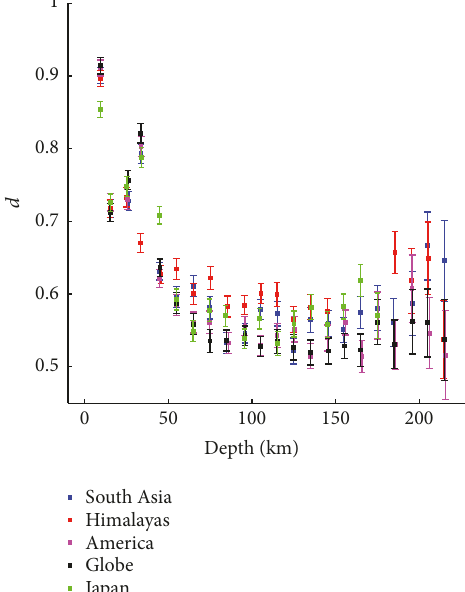
Figure 4: Variation with the depth of 𝑑 , calculated by the modified DFA for the time series of hypocenter separation distance in catalogs: South Asia, Himalayas, America, Globe, and Japan. Depth range is 0 − 230 km in 10 km